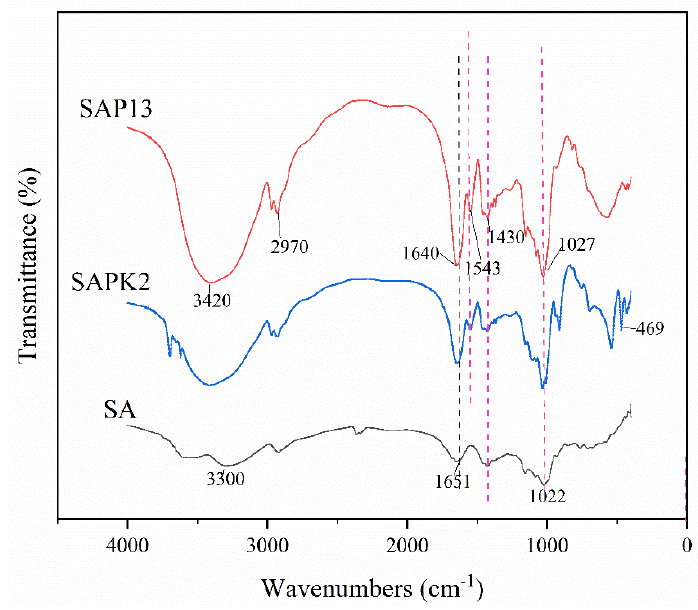
Figure 2. FTIR spectra of hydrogel beads.